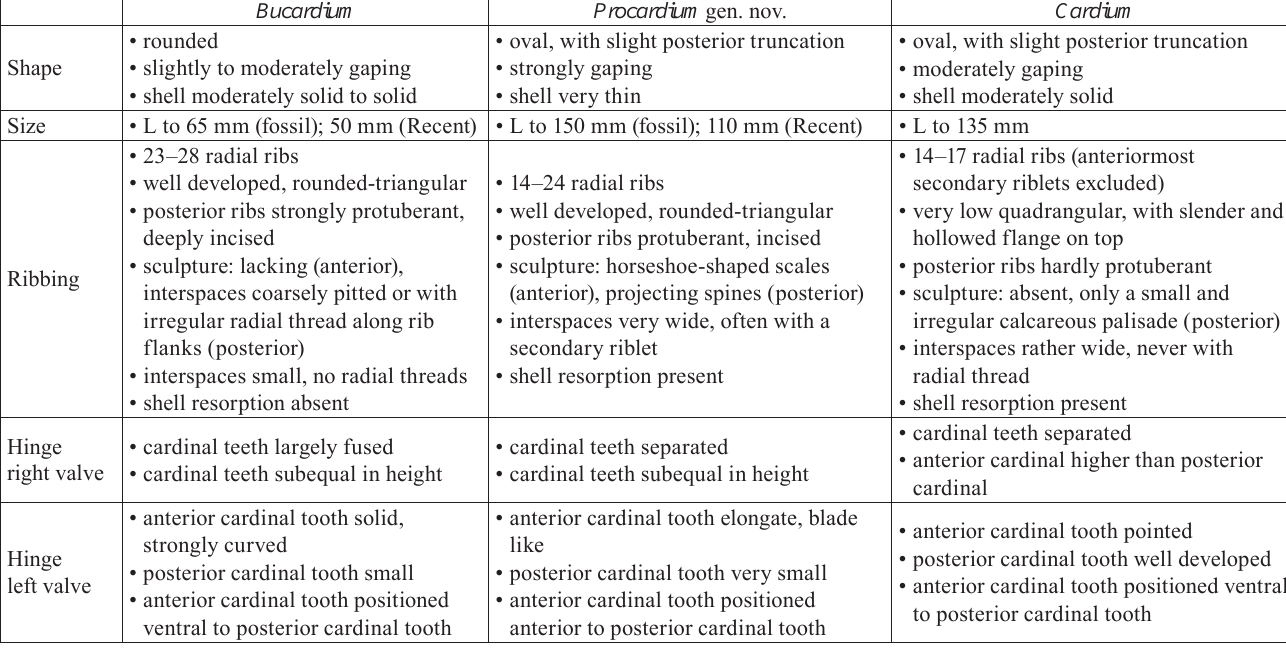
Table 1. Morphological differences between Bucardium , Procardium gen. nov., and Cardium. Bucardium Procardium gen.